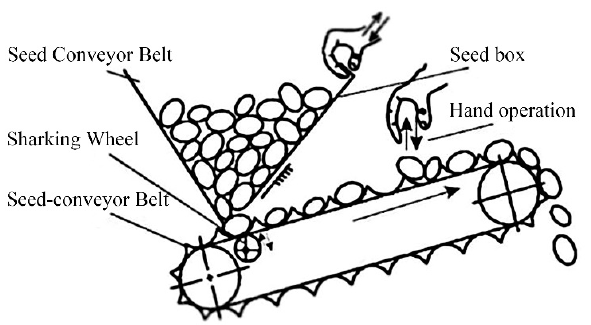
Figure 8. Cup-belt-type seed metering device. Reprinted with permission from ref. [31]. Copyright 2019 Chinese Society for Agricultural Machinery.